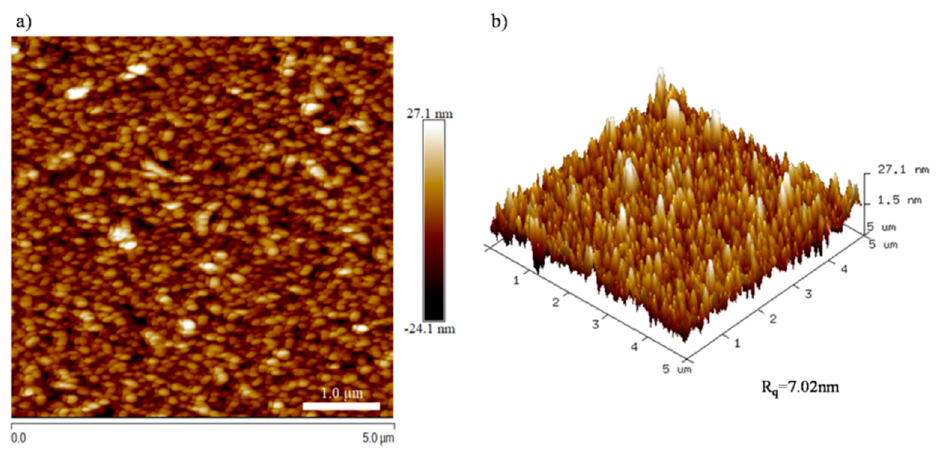
Figure 1. AFM images of VO 2 thin film ( a ) two − -dimensional image; ( b ) three − -dimensional image.